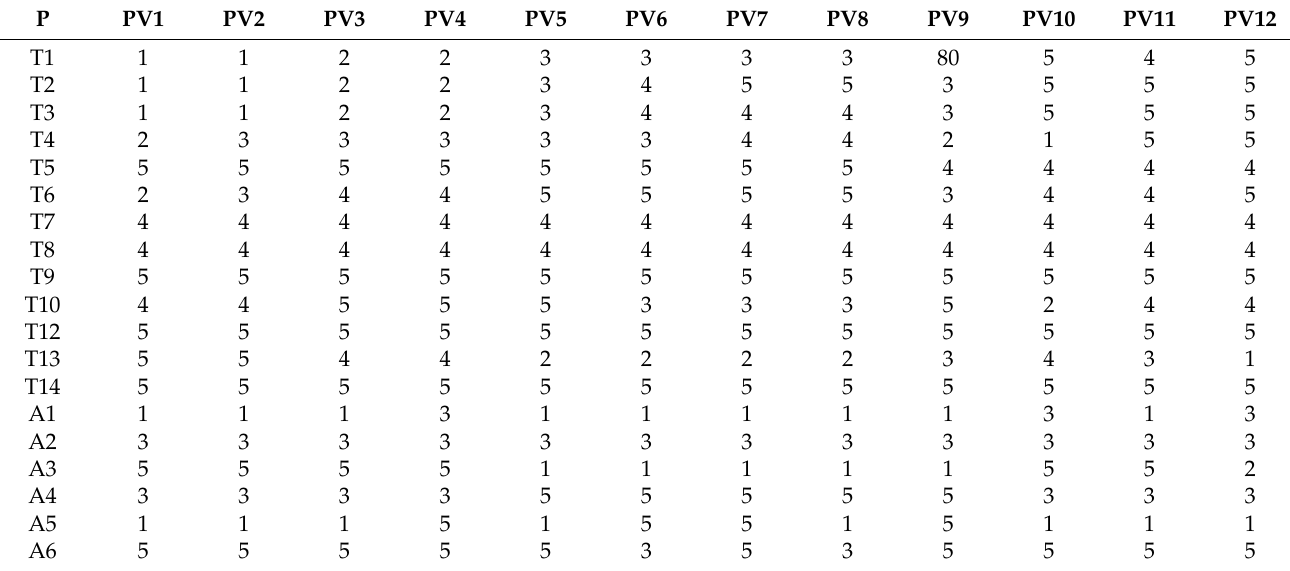
Table 15. Initial evaluation of the quality of PV criteria. Own